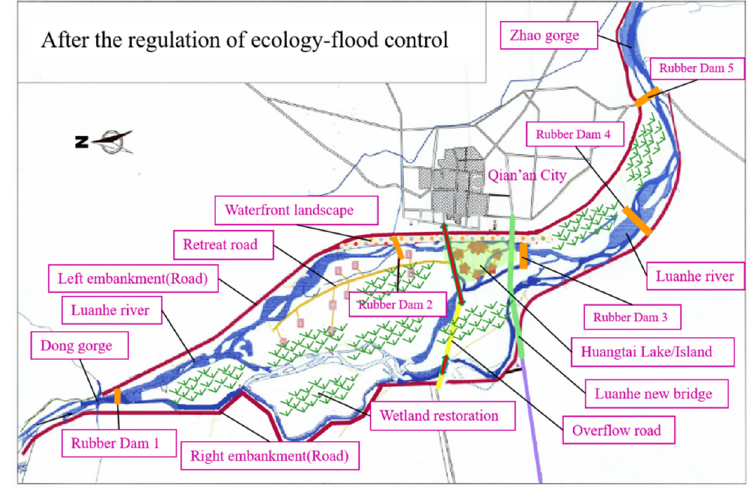
Figure 4. The working procedure and specific techniques used.